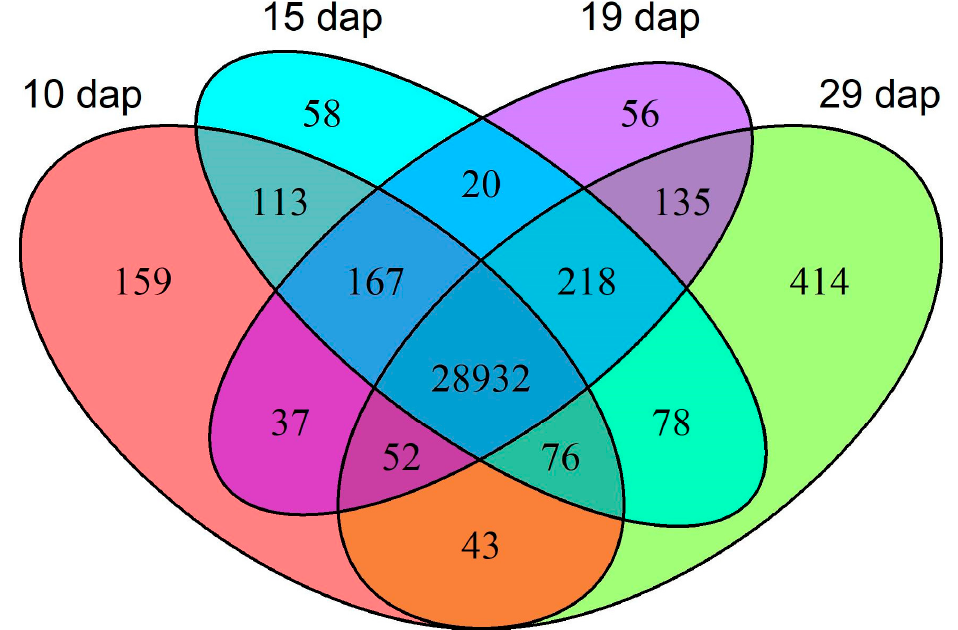
Figure 1. Number of expressed genes at 10, 15, 19 and 29 dap. Of a total 30,558 expressed genes, 28,932 were expressed in all treatments. Fewer genes were expressed in one, or a subset, of treatments.